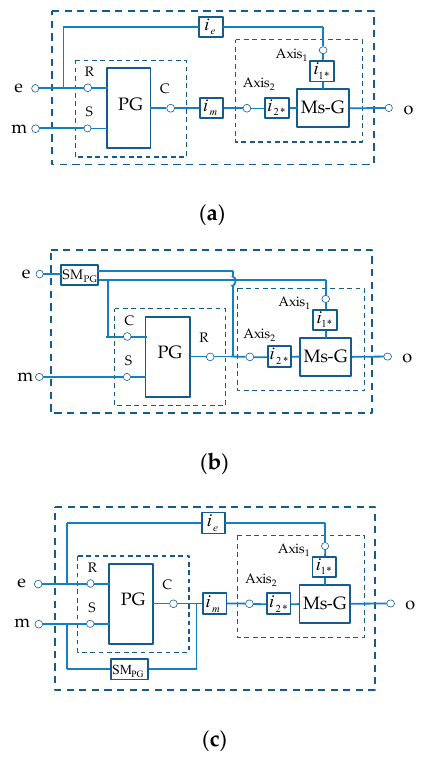
Figure 16. Port diagram of a typical architecture: ( a ) HDT; ( b ) HAST; ( c ) CGST. Table 4. Comparison of four types of SEM-PHPS